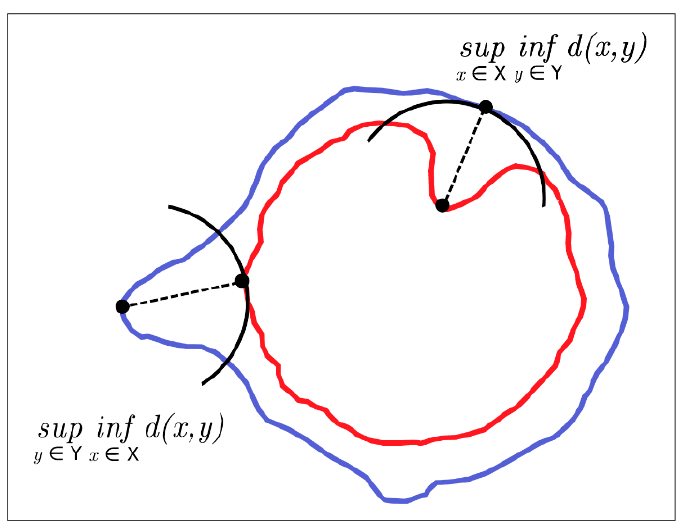
Figure 6. Schematic showing the principle of the Hausdorff distance. The dotted lines indicate h ( X , Y ) and h ( Y , X ) of the red and blue curves, which represent the outlines of two floes.